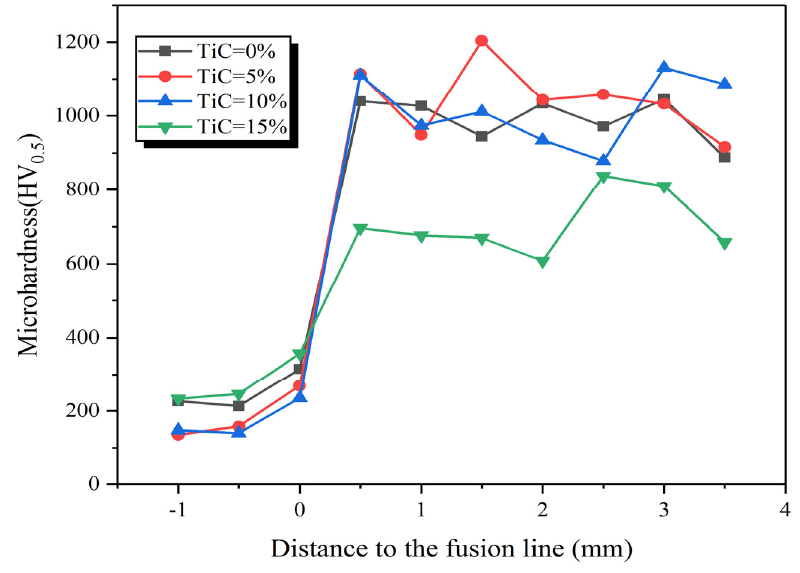
Figure 9. Microhardness of claddings with different TiC contents.